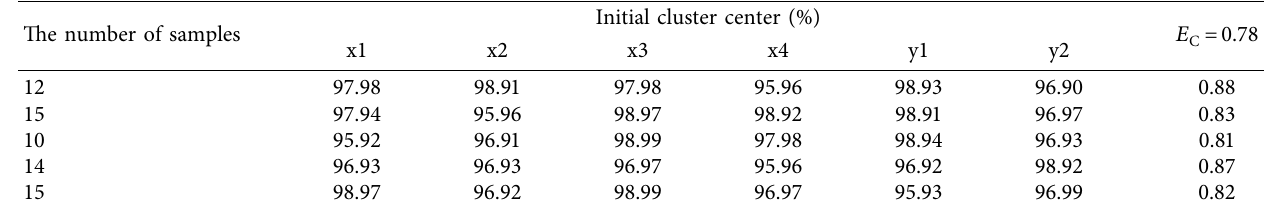
Table 1: The sample clustering.